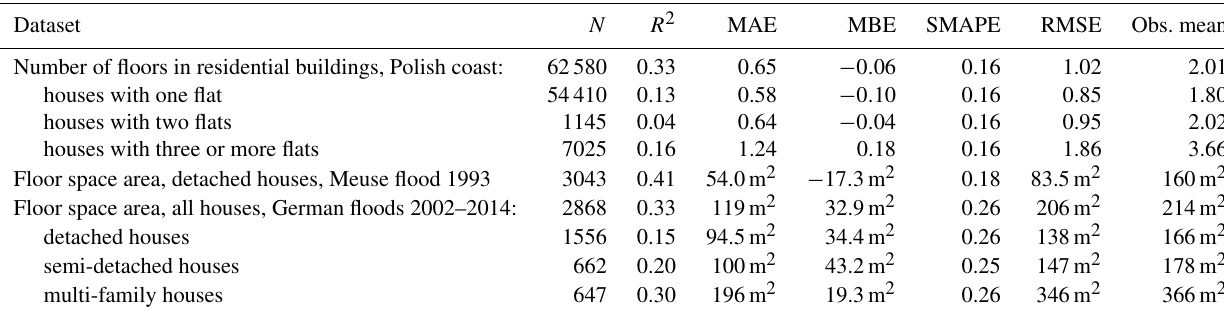
Table 3. Validation statistics for the building height prediction model (mean value of the uncertainty distribution) for various sets of residential buildings.